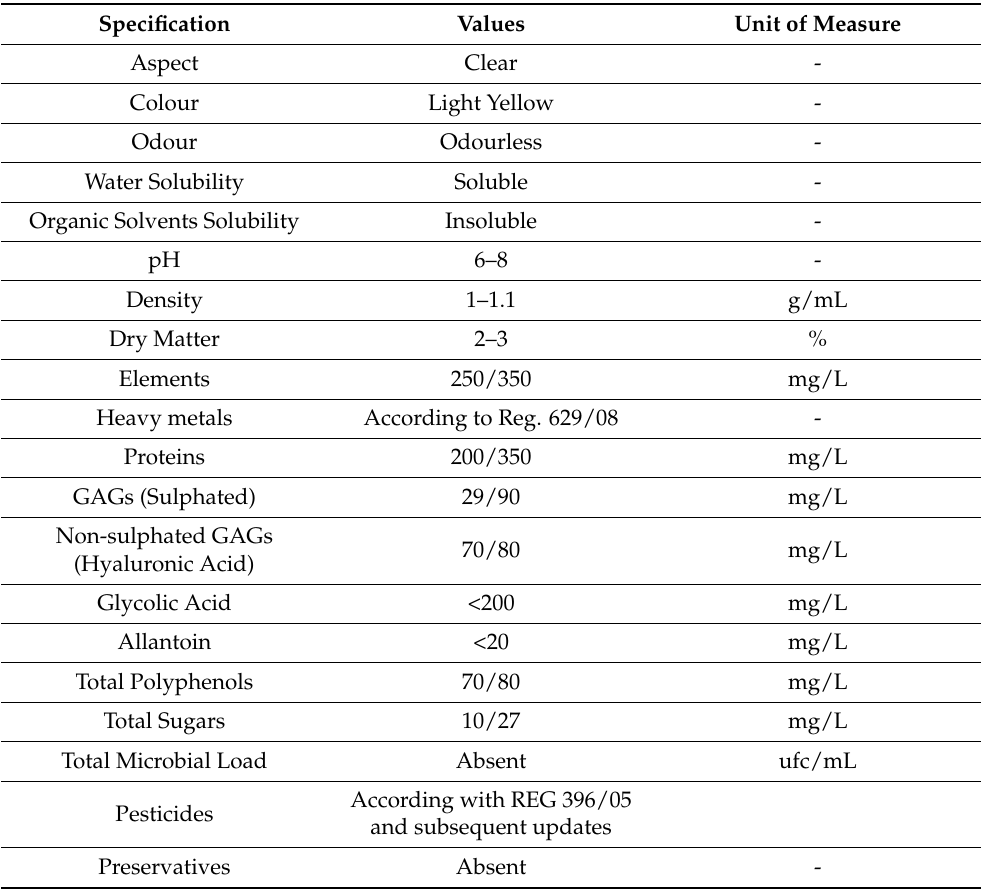
Table 1. Main physico-chemical characteristics of HelixComplex (HC) snail